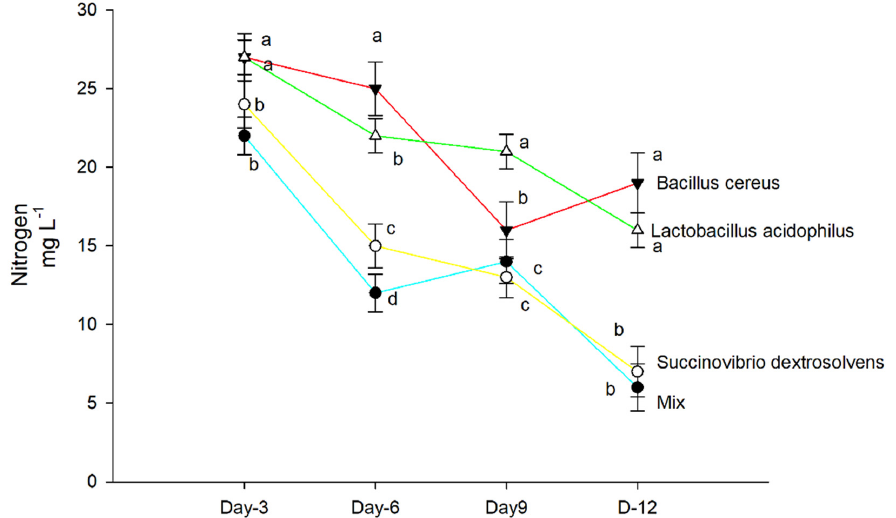
Figure 5. Dynamic of solubilized phosphorus content from the test tube on three, six, nine, and twelve days with three repetitions for each bacterium every three days. Means with different letters indicate significant differences among treatments. Statistical analysis was performed using Duncan’s test ( p < 0.05). Black triangle = B. cereus ; Black cicle= L. acidophilus ; white circle = S. dextrinosolvens; white triangle = Mix.